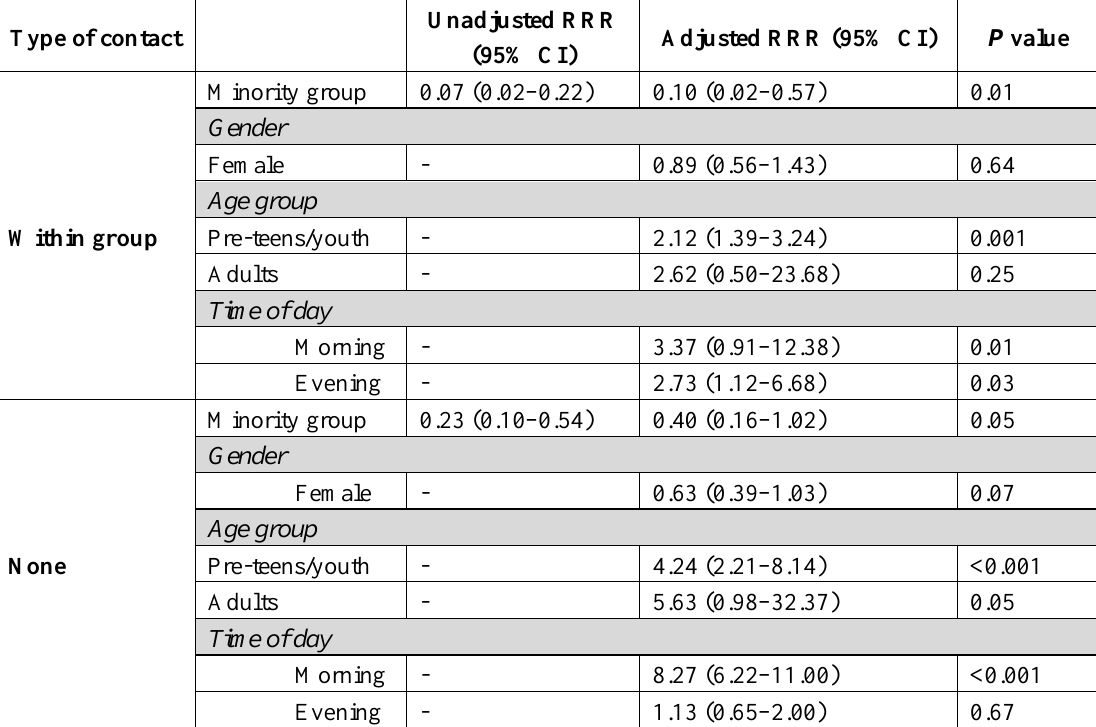
Table 3. Multivariable adjusted associations between type of contact and socio-demographic characteristics. Type of contact